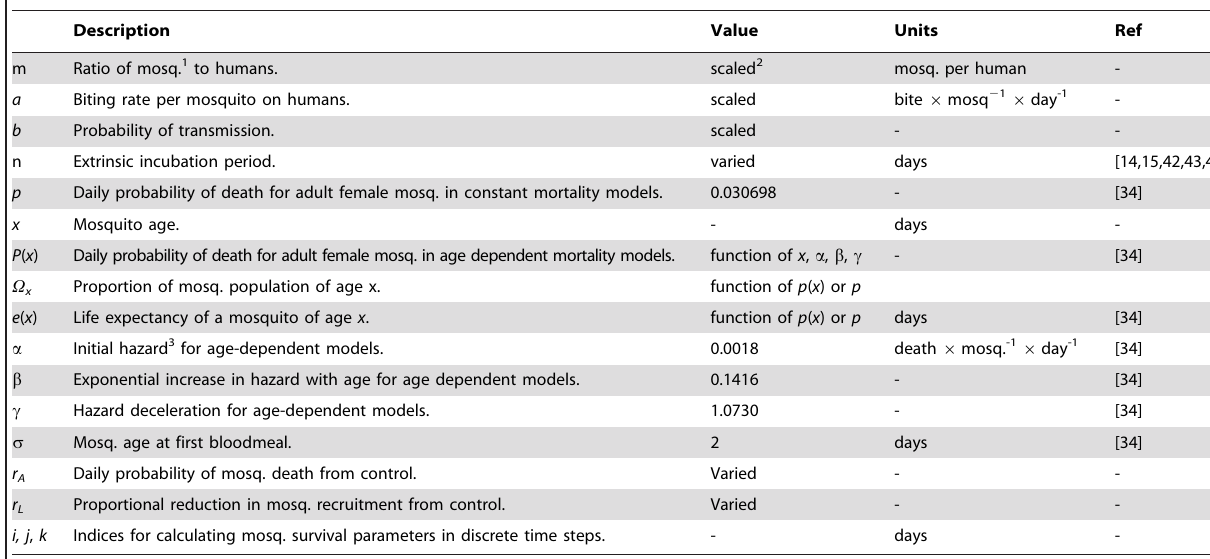
Table 1. Description of model parameters.